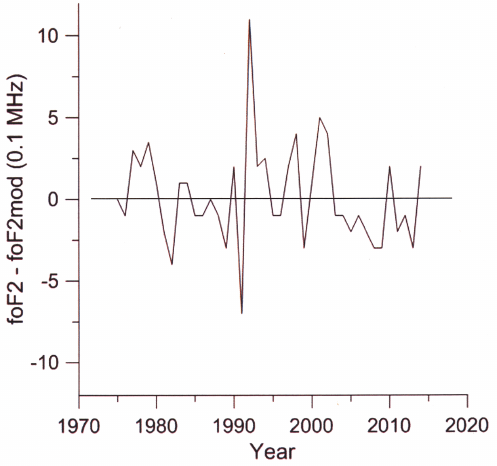
Figure 3. Residuals (cid:49) fo F2 (0.1MHz) after removal of solar activity (F10.7) influence (Eq. 1), yearly values, for Chilton. Thin horizontal line – reference (zero) level.